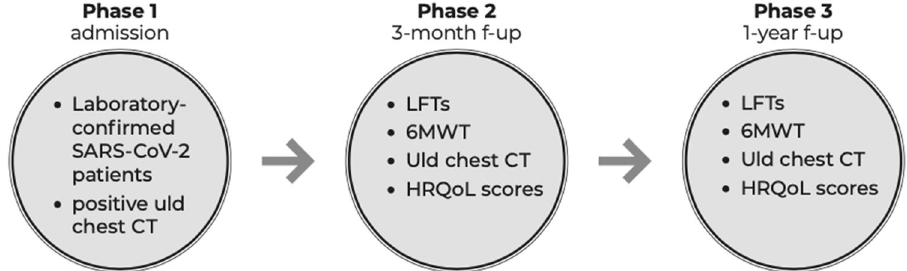
Fig. 1 Study timeline. We represent the study timeline, with the 3 phases (admission, 3-month f-up and 1-year f-up) and the exams performed in each phase.